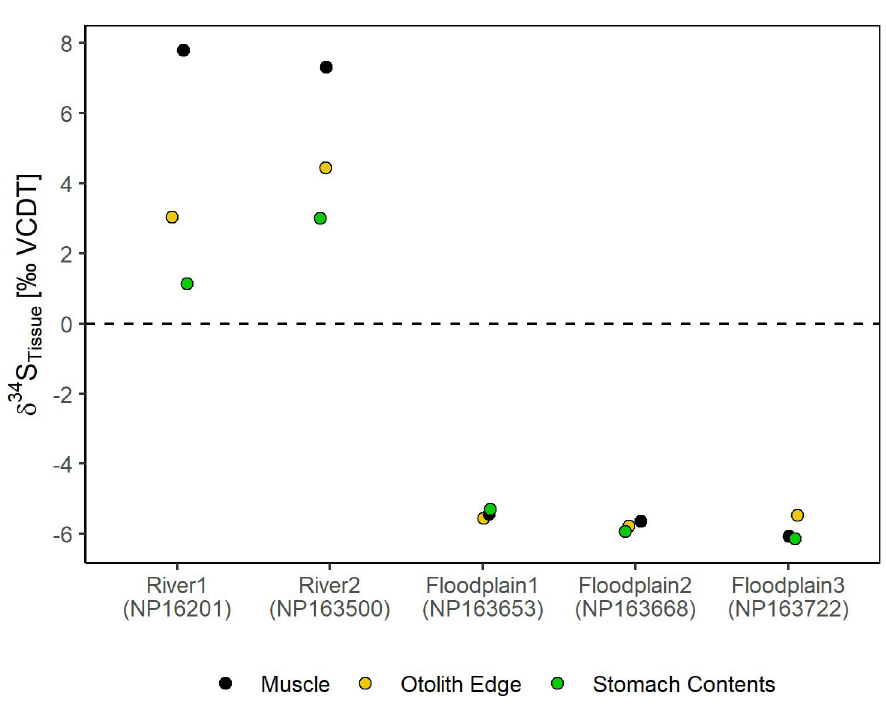
Fig 8. Comparison of the otolith edge (30 μ m) δ 34 S Otolith values with the δ 34 S muscle and δ 34 S stomach values for two river and three floodplain fish.